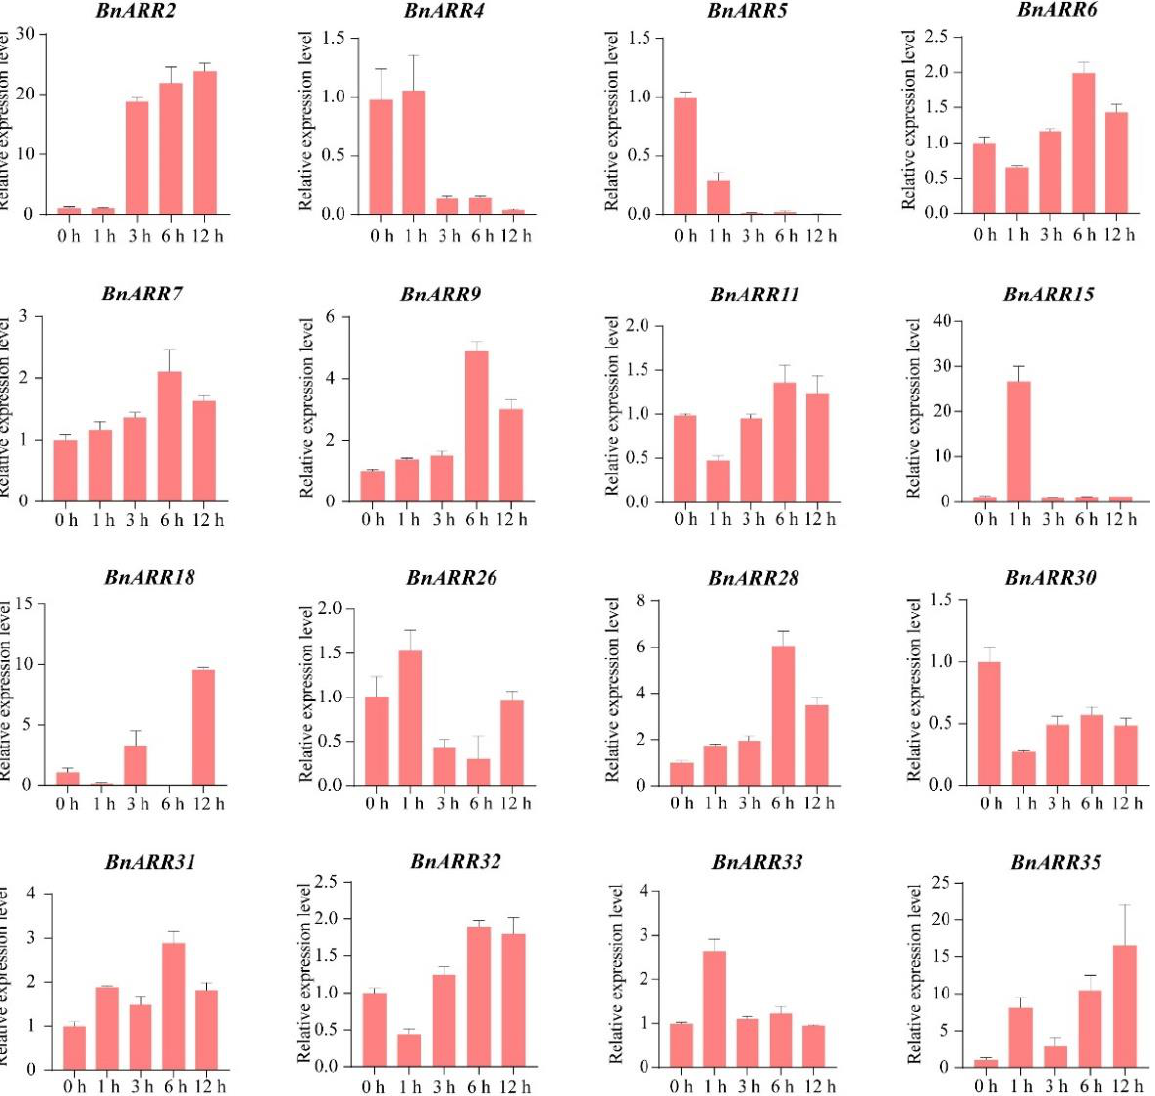
Figure 11. Type-B BnARRs expression in response to ABA treatment. The data was represented as mean ± standard deviation ( n = 3).